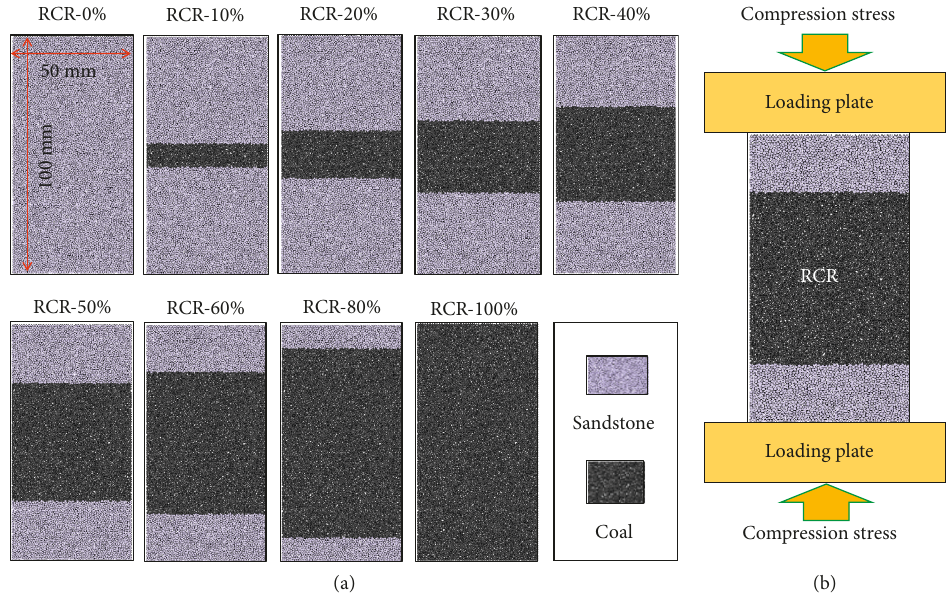
Figure 3: Numerical RCR samples with height ratios ranging from 0% to 100% (a), and the framework of uniaxial compression test (b).